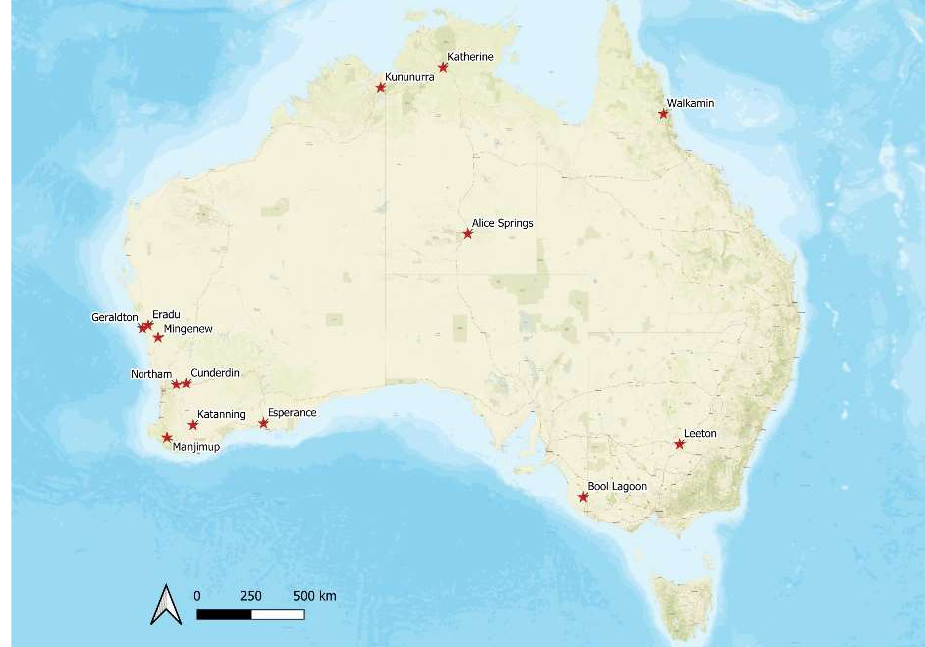
Figure 1. Map of trial sites. Table 3. Latitude, longitude, altitude and soil texture at trial